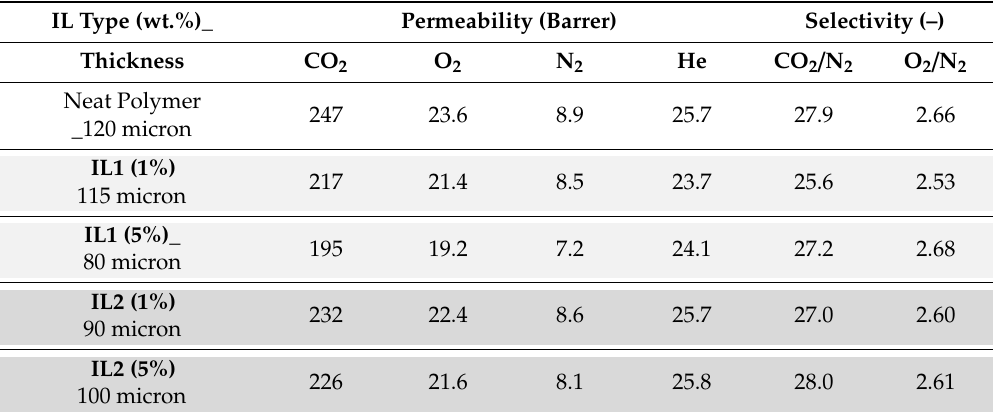
Table 3. Gas permeability of Pebax ® Rnew and Pebax ® Rnew / IL blend membranes at 25 ◦ C. IL Type (wt.%)_